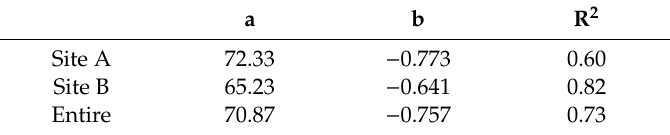
Figure 17. Correlation between the total cone resistance and dynamic cone penetration index. The red line indicates the trend line for the entire data set. Table 2. Parameters of the correlation between the total cone resistance and dynamic cone penetration index.